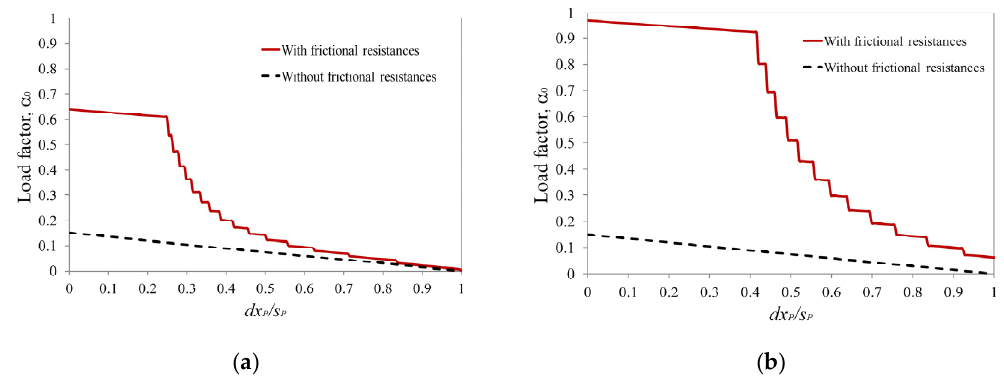
Figure 6. Influence of the frictional resistance due to interlocking between orthogonal walls after the hinge formation [13,49]. Pushover curves with unit aspect ratio h b / l b = 1/3 ( a ) and h b / l b = 1/5 ( b ).